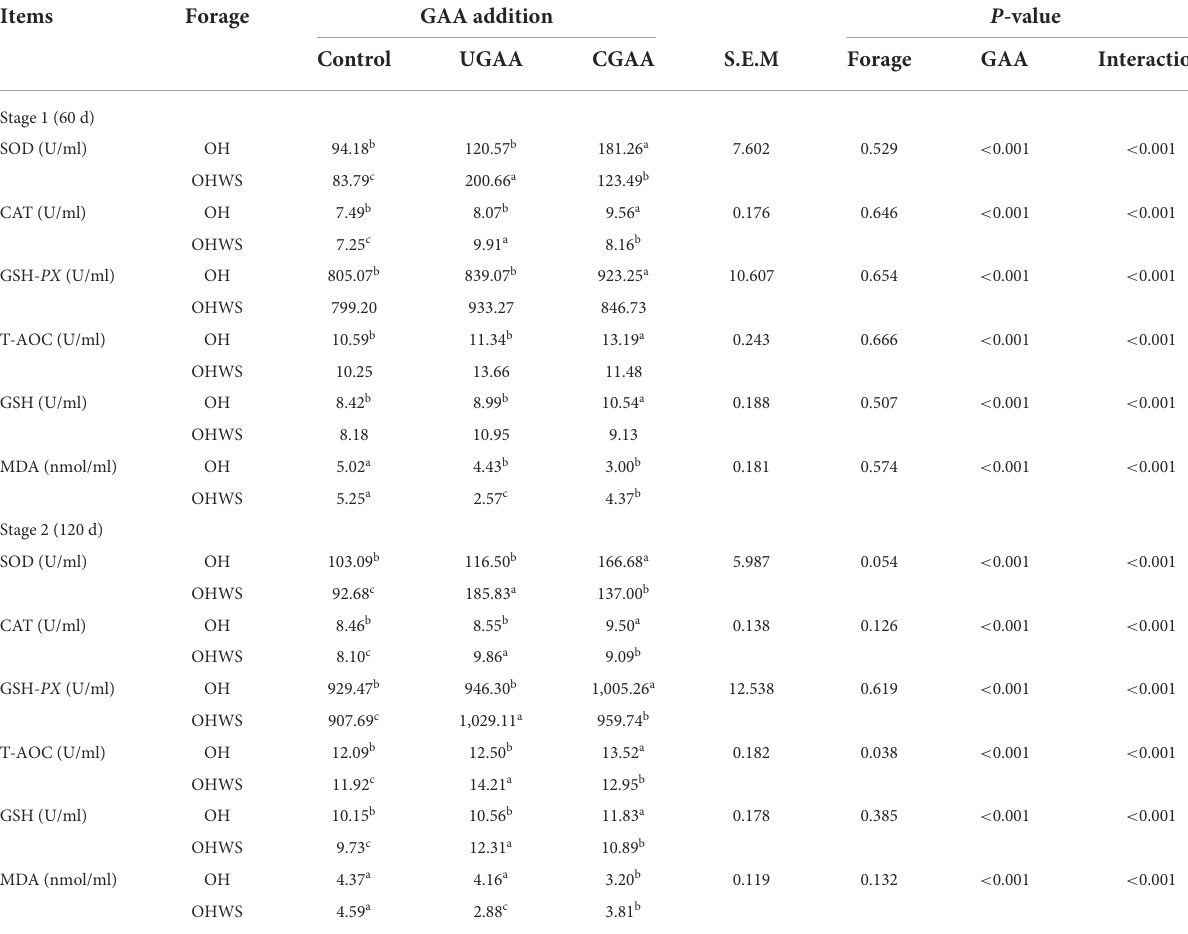
TABLE 7 Effects of forage type and guanidine acetic acid (GAA) addition on serum antioxidant index.